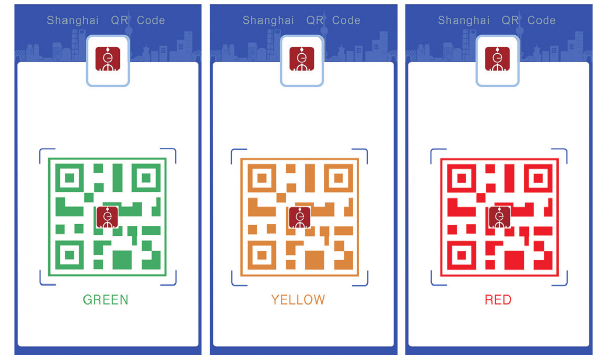
Figure 1: User interface for Shanghai health QR code